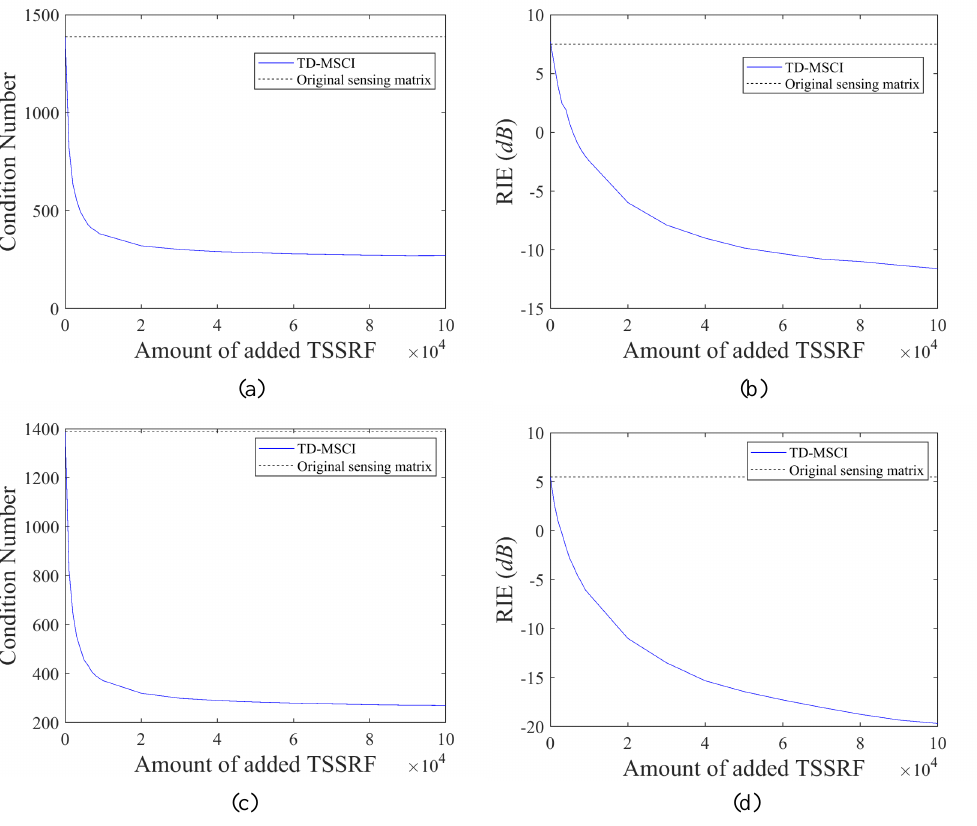
Figure 9. Variation curve of condition number and RIE in TD-MSCI with unused TSSRF. ( a , c ) are the variation curves of condition number with target 1 and 2. ( b , d ) are the variation curves of RIE with target 1 and